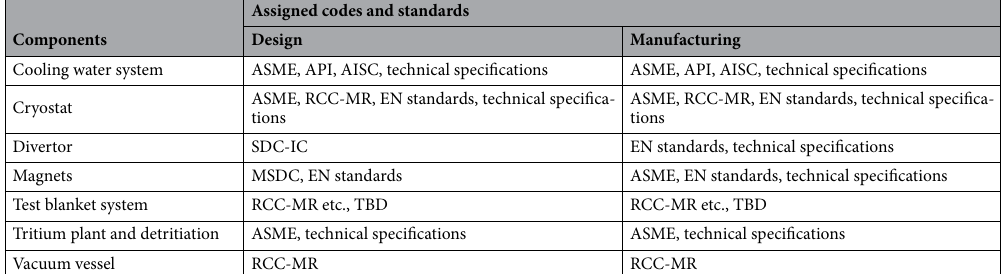
Table 4. Engineering codes and standards for the design and manufacture of major tokamak components of ITER 56,57 . In addition to codes and standards that have already been developed in relevant engineering fields (e.g., ASMES, API, AISC, RCC-MR, EN standards), specifications established for the design and development stage (e.g., MSDC, SDC-IC) were applies mutatis mutandis as guidelines. ASME: American Society of Mechanical Engineers; API: American Petroleum Institute; AISC: American Institute of Steel Construction; RCC-MR: Regles de Conception et de Construction des Materiels Mecaniques des ilots nucleaires RNR; EN: European Norm; MSDC: Material Structural Design Criteria; SDC-IC: Structural Design Criteria for In-Vessel